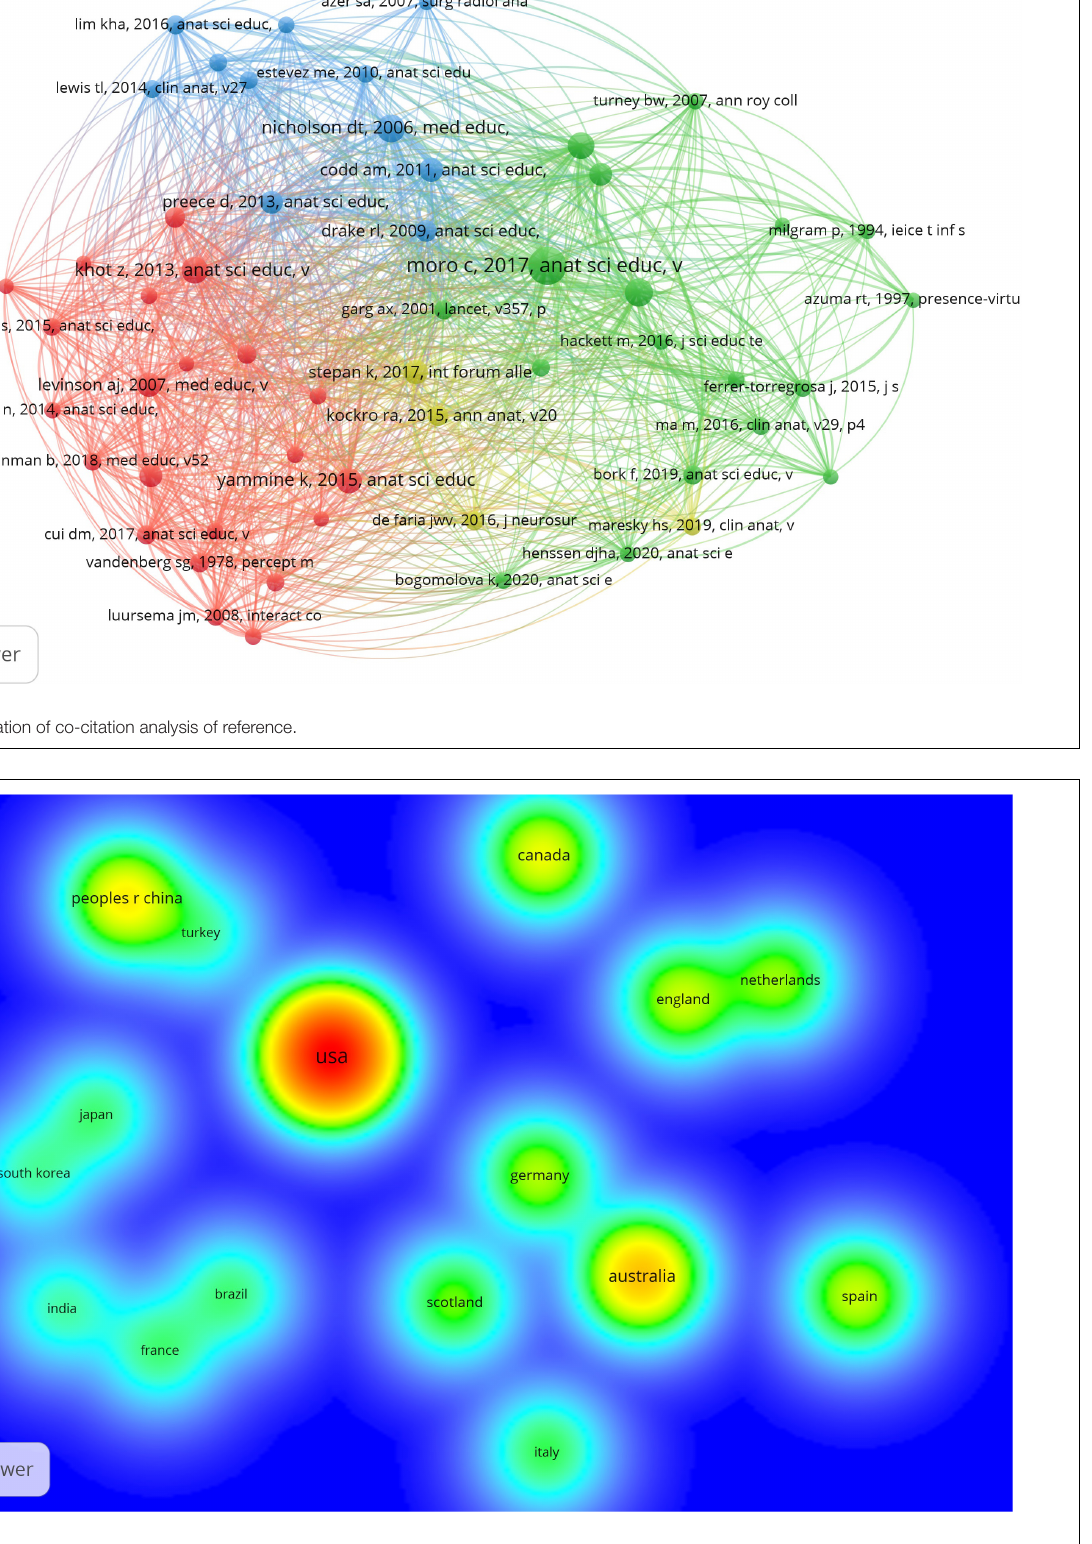
FIGURE 5 | The co-author relationship of